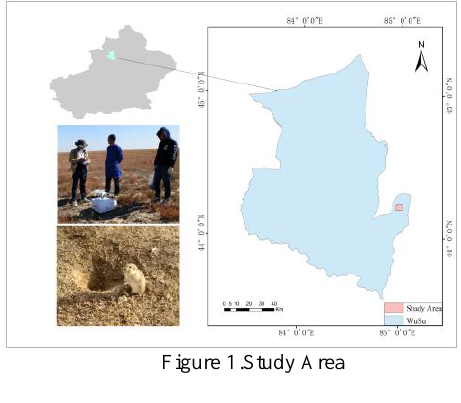
Figure 1.Study Area